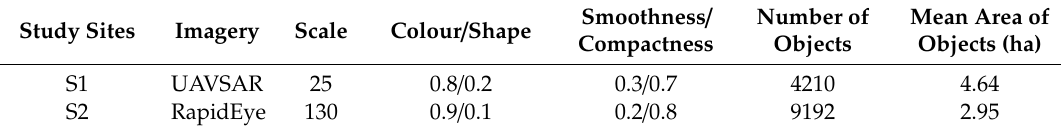
Table 2. Parameters used in the multi-resolution segmentation algorithm in the two study